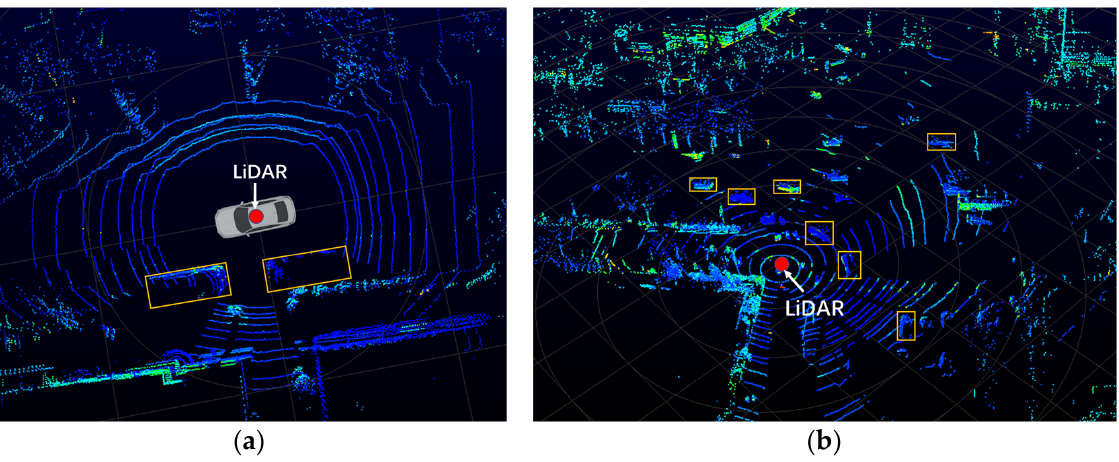
Figure 4. Visualization of point clouds collected by LiDAR installed at different heights. ( a ) Point cloud collected by vehicle LiDAR at a height of 1.5 m. ( b ) Point cloud collected by roadside LiDAR at a height of 4.5 m.